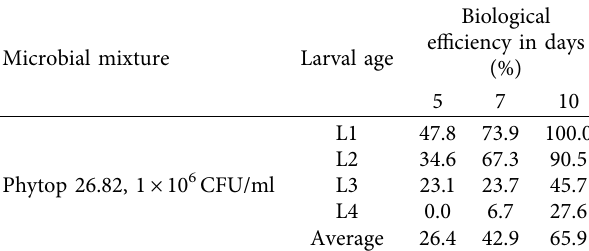
Table 1: The biological efficacy of the drug Phytop 26.82 at a dose of 1 × 10 6 CFU/ml by phase and age of larvae (from L1 to L4) in laboratory experiments on days 5, 7, and 10. The arithmetic mean of the biological effectiveness was calculated as a percentage for the reporting